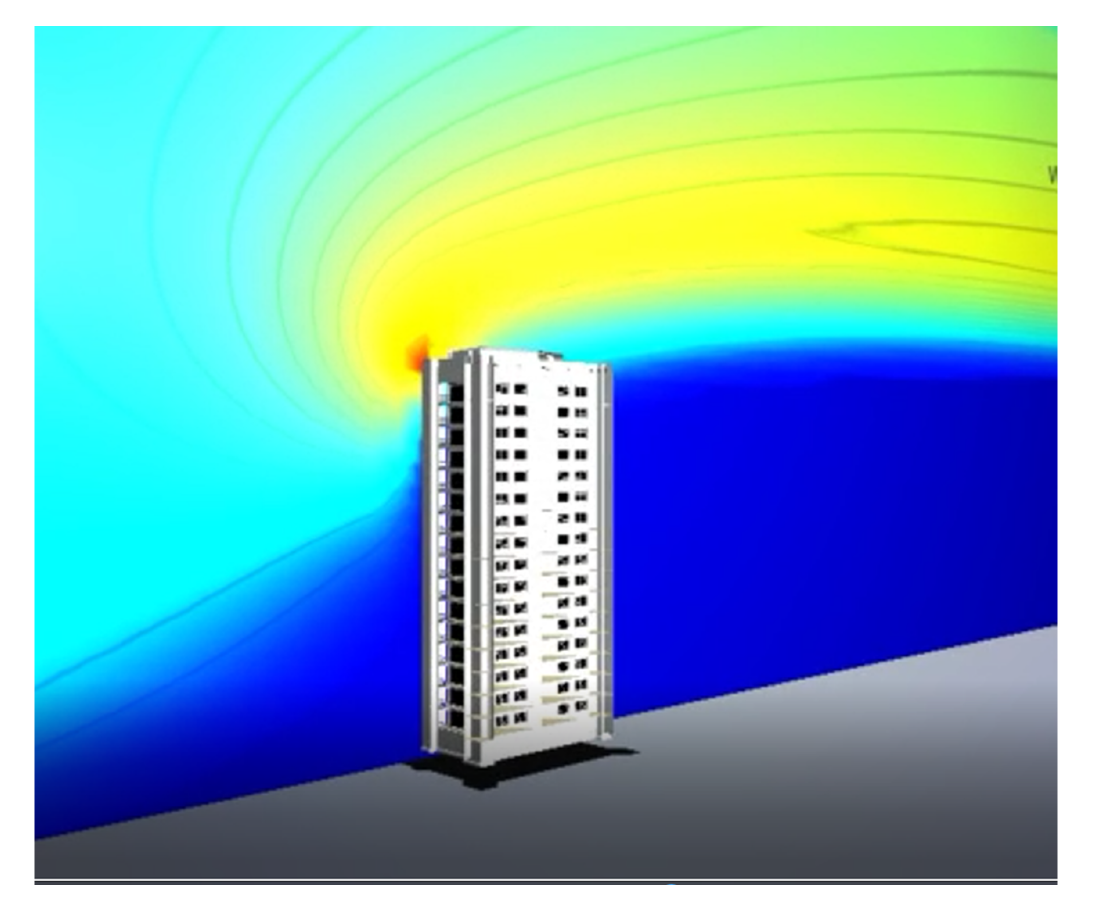
Figure 3. Re-creation on the basis of Mertens [38] for wind acceleration over the windward upper edge of a